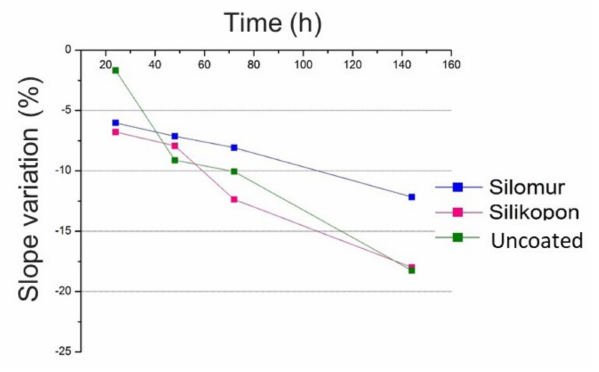
Figure 4. FIMEC slope as a function of ageing